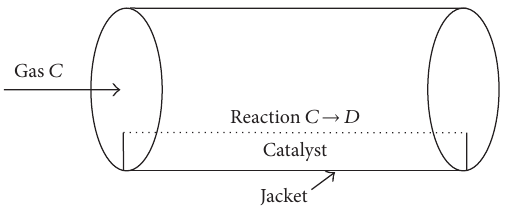
Figure 1: Sketch of a catalytic packed-bed